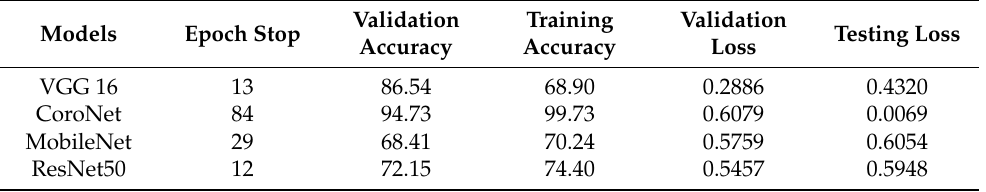
Table 6. Training performance of the CNN models in the present